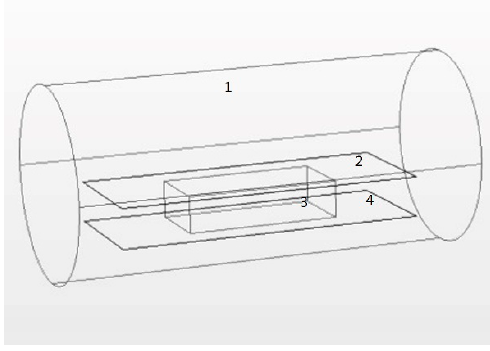
Figure 2. Drying tank of high frequency vacuum.